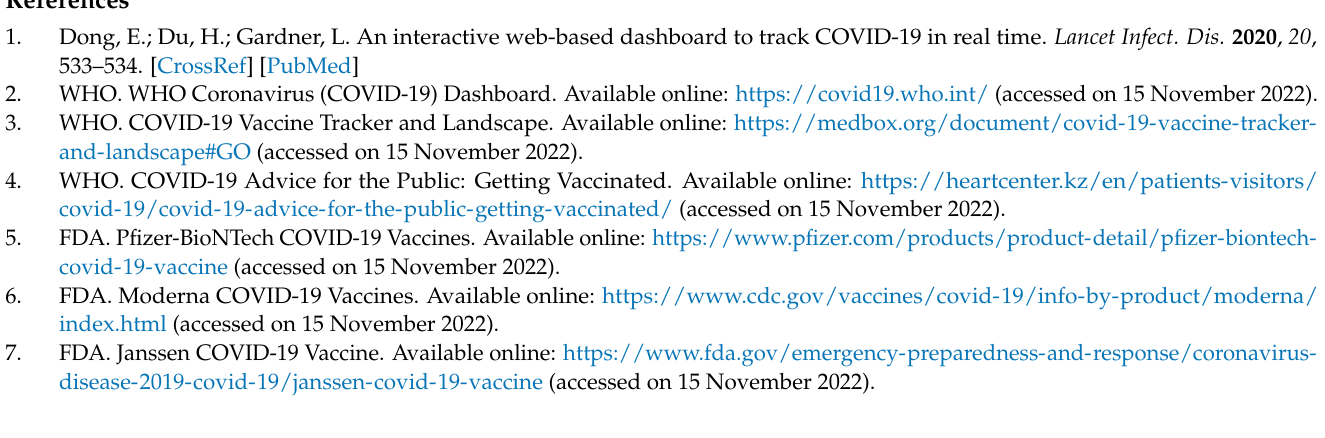
strategy; Table S1: Clinical information of vaccinated participants; Table S2: Clinical information of the convalescent participants; Table S3: Antibodies used for flow cytometry